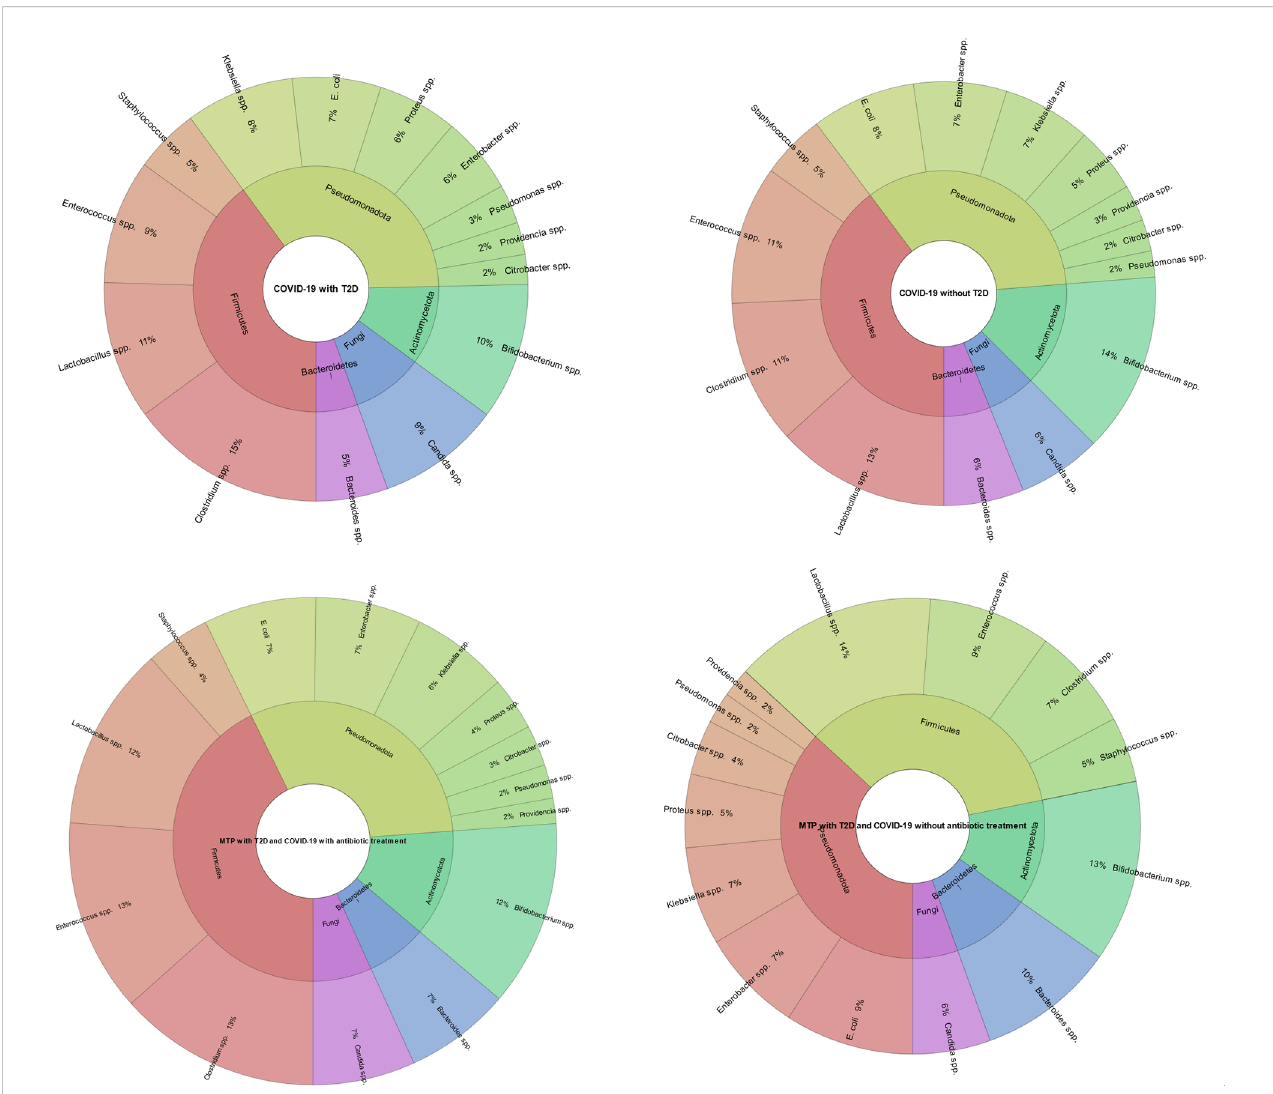
FIGURE 6 Comparison of gut microbiota composition in patients with COVID-19 and T2D, and gut microbiota composition in metformin-treated patients. The results indicate that the patients with COVID-19 and T2D had a lower abundance of the genus Bi fi dobacterium (P=0.000) and Lactobacillus (P=0.000) and a higher abundance of the genus Candida (P=0.000) compared to patients with COVID-19 but no T2D. Also, the metformin-treated group without antibiotic treatment had a higher abundance of the genus Bacteroides (P=0.000), E. coli (P=0.005), Lactobacillus (P=0.000), and a lower abundance of the genus Clostridium (P=0.000) and Enterococcus (P=0.000) compared to the metformin-treated group with antibiotic treatment. This fi gure illustrates the impact of metformin treatment and antibiotic treatment on gut microbiome composition in patients with COVID-19 and T2D and the difference in gut microbiome composition between patients with COVID-19 and T2D and patients with COVID-19 but no